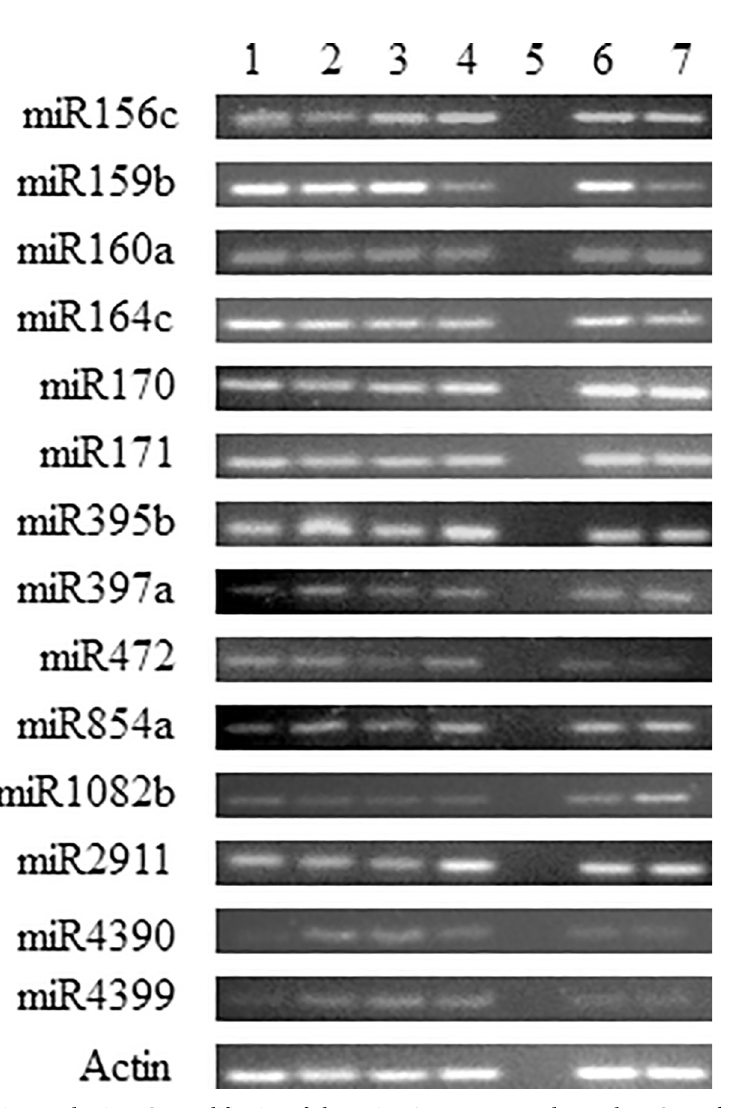
Fig 6. End point PCR amplification of plant miRNAs on cassava and Jatropha. PCR products of 60 bp were amplified. Lanes 1 to 4 are three infected and one non—infected cassava plant samples, respectively: S4C4, S2C6, S4C6, B2C15,–RT control. Lanes 6–7 are one infected and one non-infected Jatropha plant samples, respectively: K5J5, S4J12. Actin (76 bp) was used as internal control.